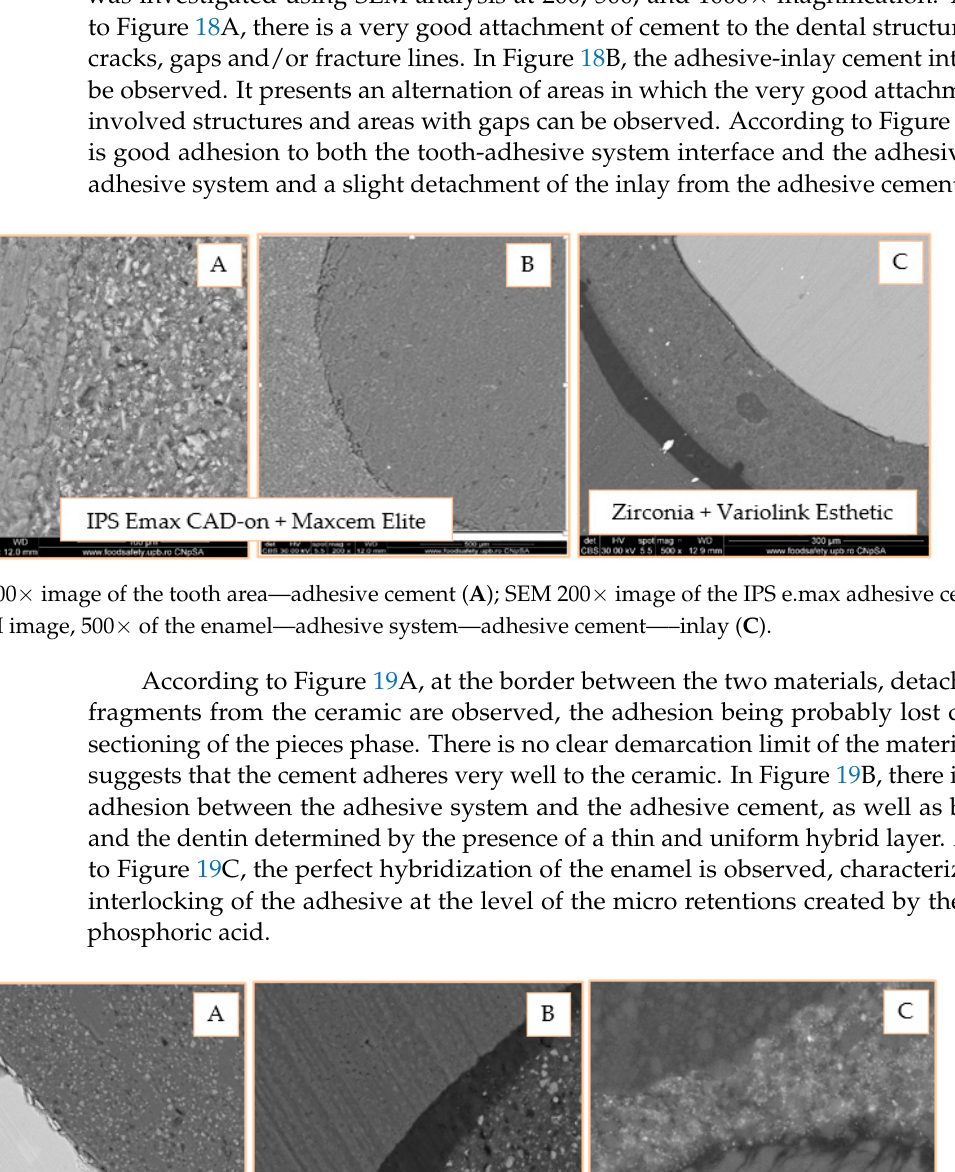
Figure 17. Mechanical strength of dental materials and shear stresses recorded at interface: ( a ) ceramic; ( b ) adhesive ce- ment.